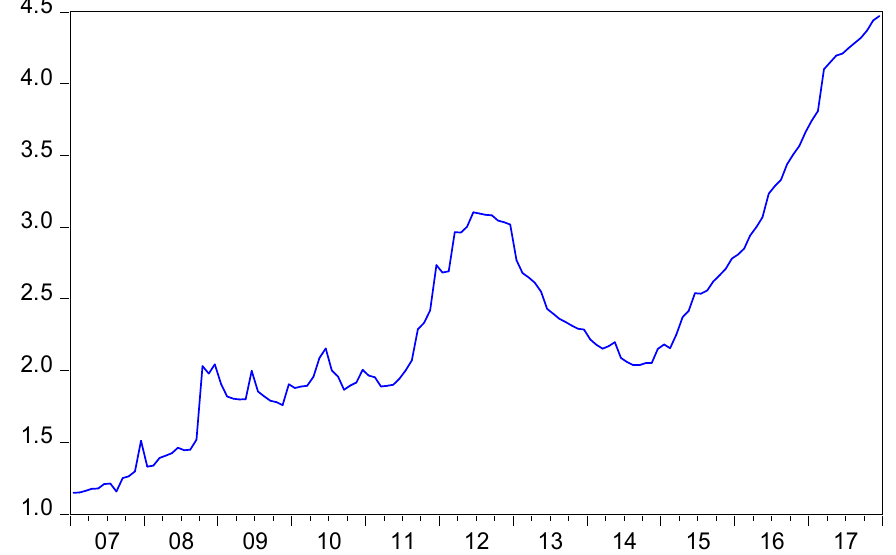
Figure 2. ECB’s total balance sheet assets. Source: ECB statistical data warehouse.